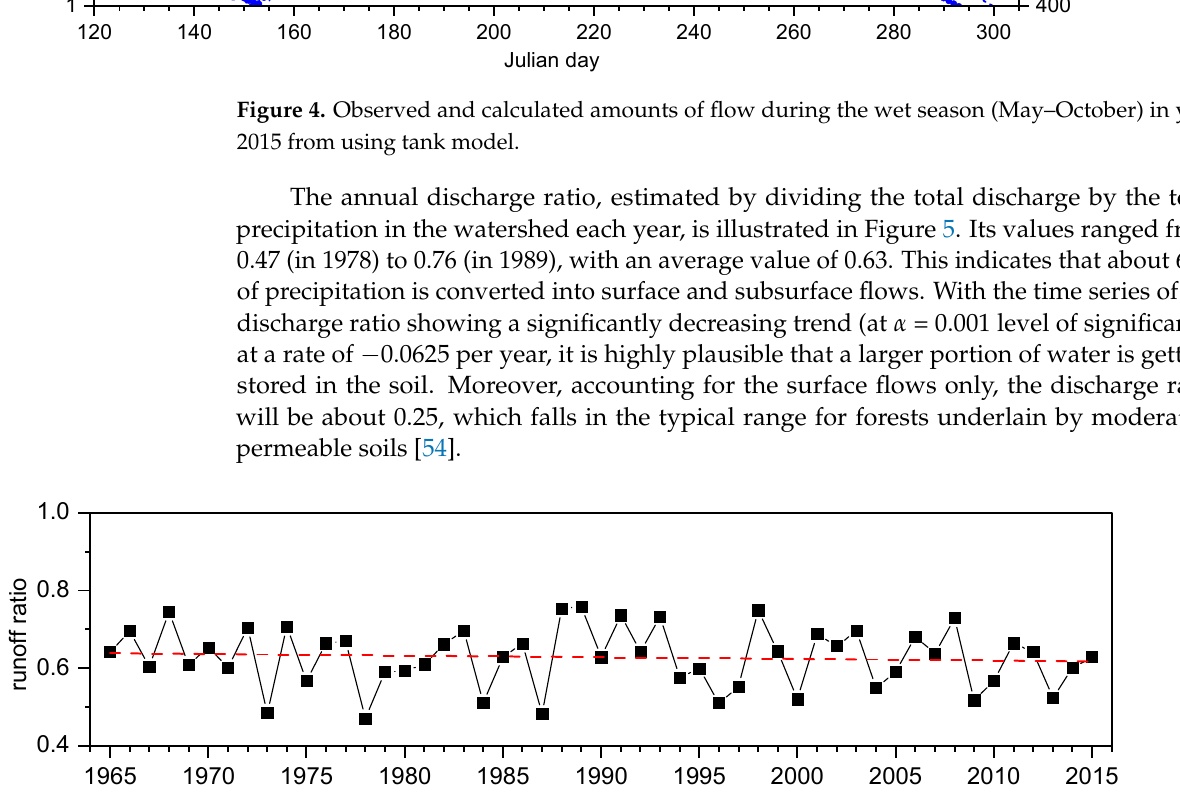
Figure 5. Annual time series of discharge ratio from 1965 to 2015 in the Ogouchi Dam watershed.